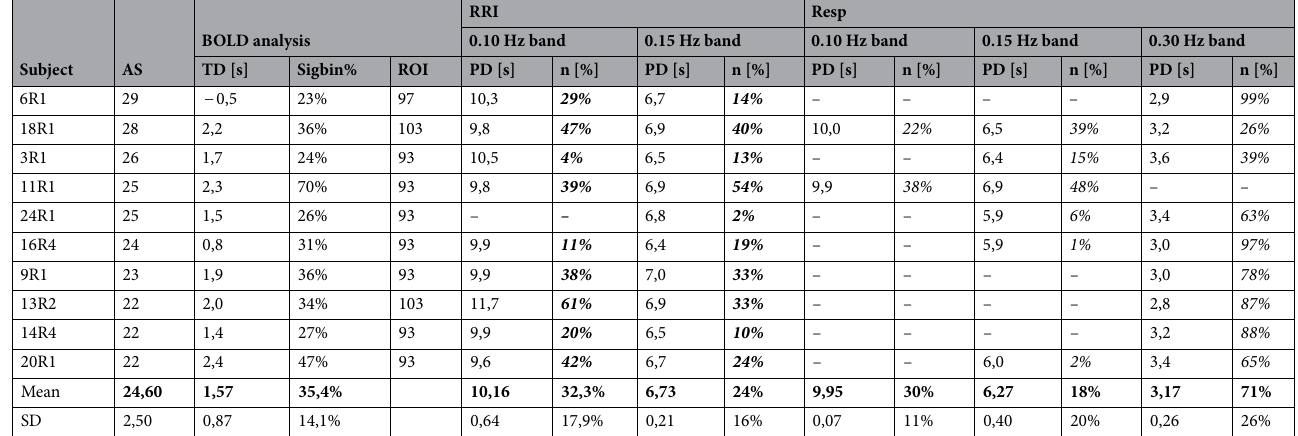
Table 1. A summary of the results of the wave-by-wave analyses from 10 fMRI participants with high anxiety (modified from 12 ). In addition, the results of phase-coupling between BOLD oscillations in brainstem (ROIs with the largest time delay are indicated) and RRI oscillations are